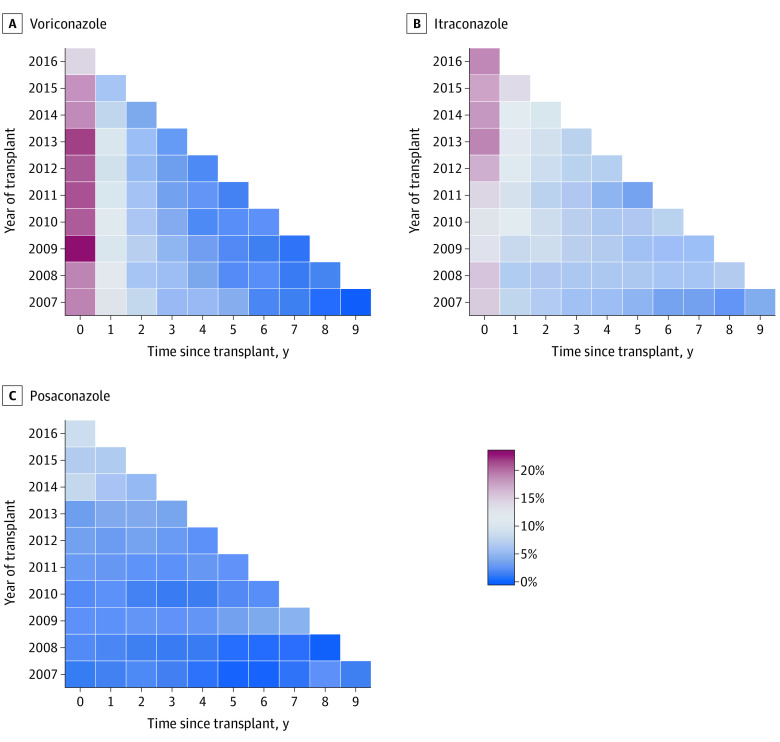
Antifungal Medication Exposure as a Function of Transplant Calendar Year and the Time Since TransplantMedication use for each lung transplant was assessed every 30 days (interval), and the colors within the boxes represent the proportion of intervals in which an antifungal medication was observed for the specific time since transplant–calendar year combination. The darkest red boxes correspond to more than 20% and the darkest blue boxes to less than 5% of intervals. The percentages are calculated using only intervals with known exposure status.